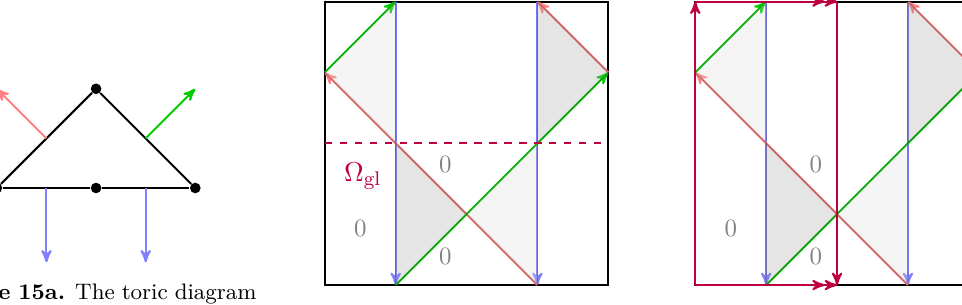
Figure 15c. The five-brane di- agram of C 2 / Z 2 × C and the Klein bottle resulting from the glide orientifold.